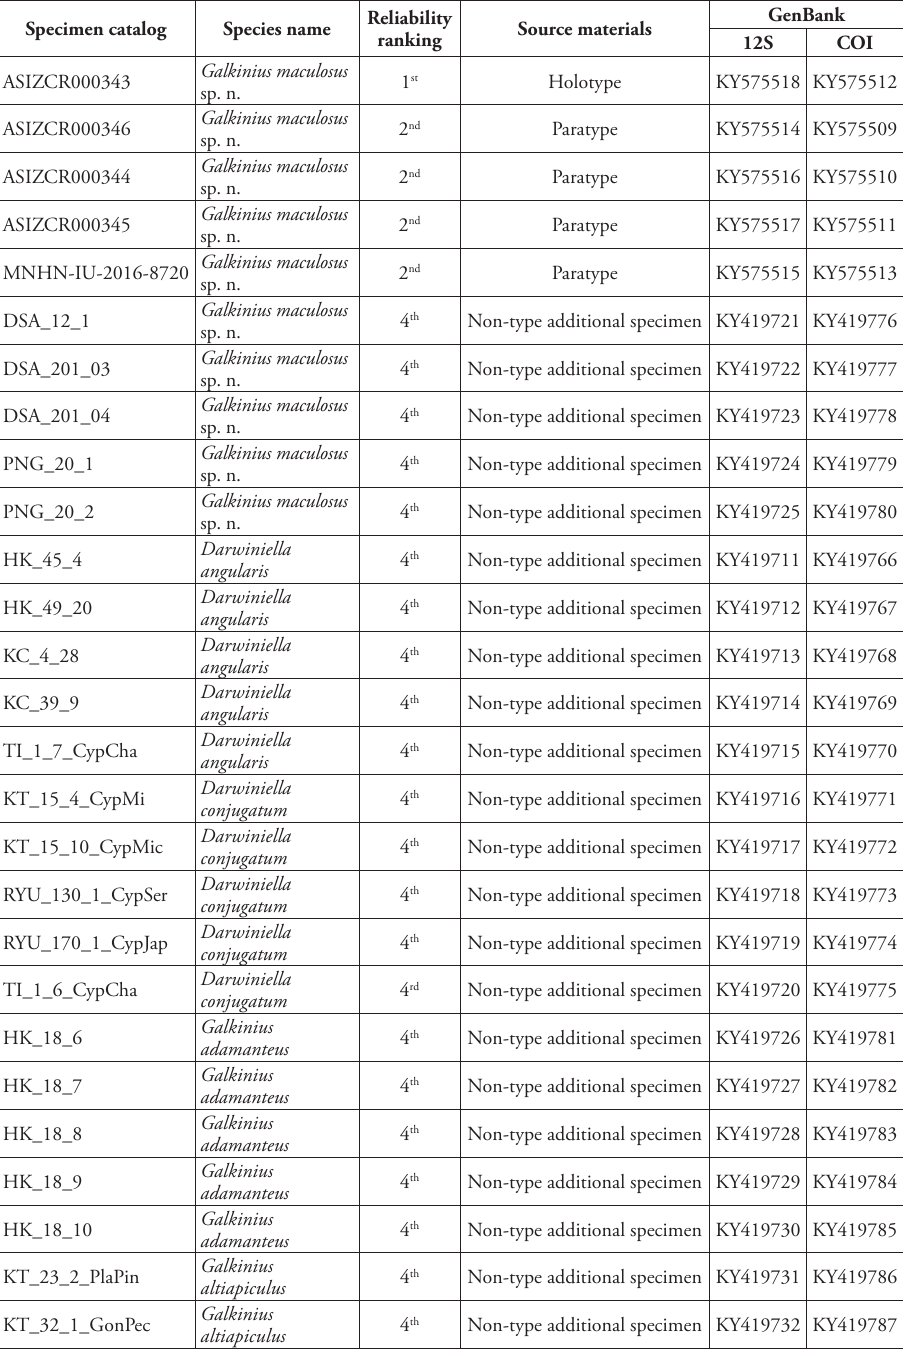
Table 1. Reporting table of ranking sequence reliability and accession numbers of GenBank